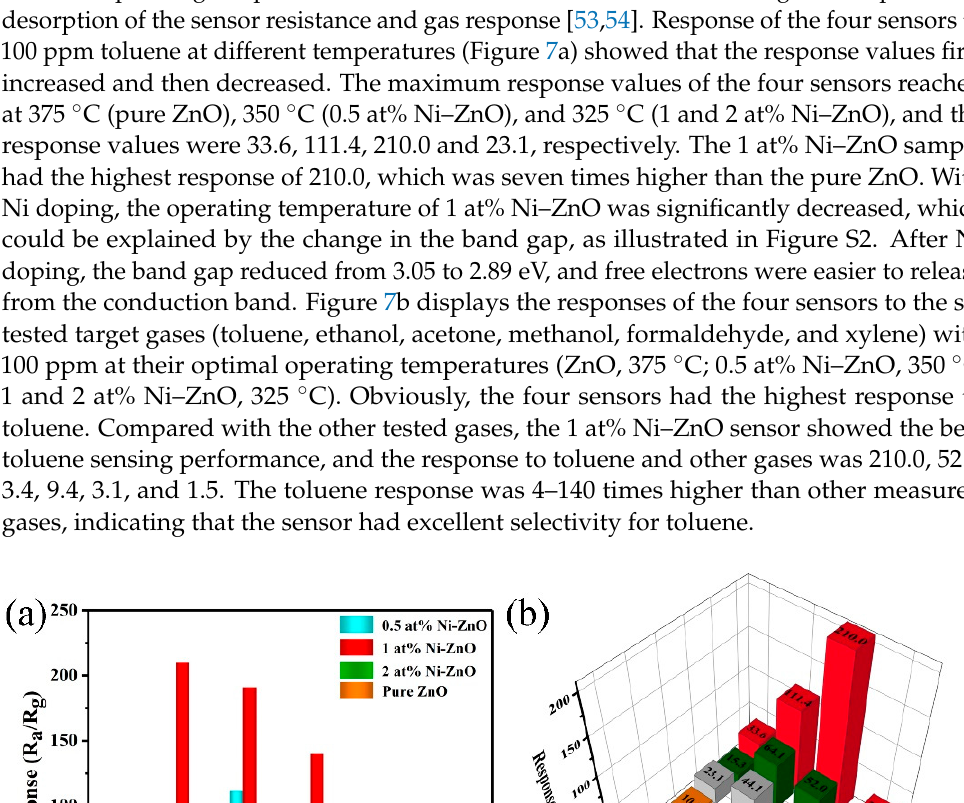
Figure 8. ( a , b ) The dynamic response curves of the four sensors to toluene with different concentra- tions at 375 °C (pure ZnO) and 325 °C (Ni–ZnO samples). ( c , d ) The response of the pure, 0.5, 1, and 2 at% Ni–ZnO sensors to (0.5–100 ppm) toluene.